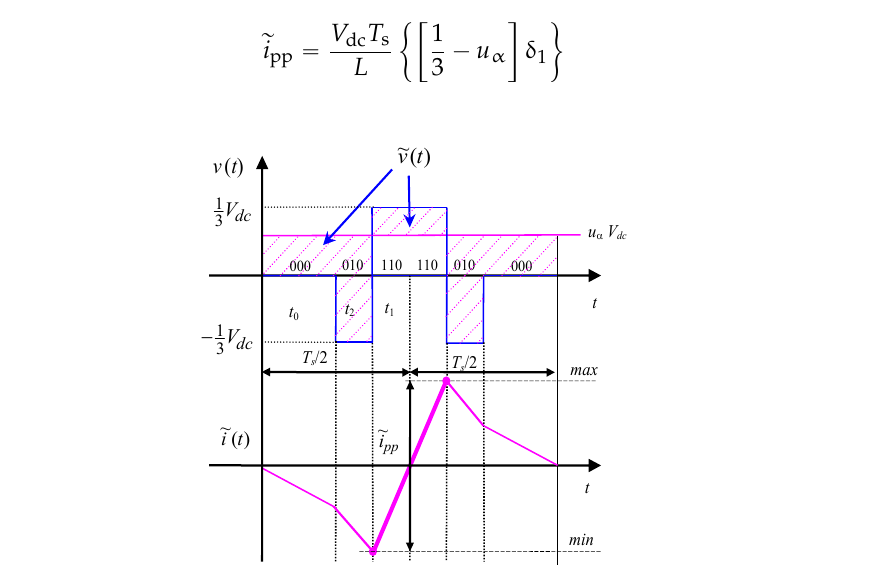
Figure 5. Output voltage and current ripple for DPWM − technique in one switching period (sector II, 0 ≤ u α ≤ 1/3).